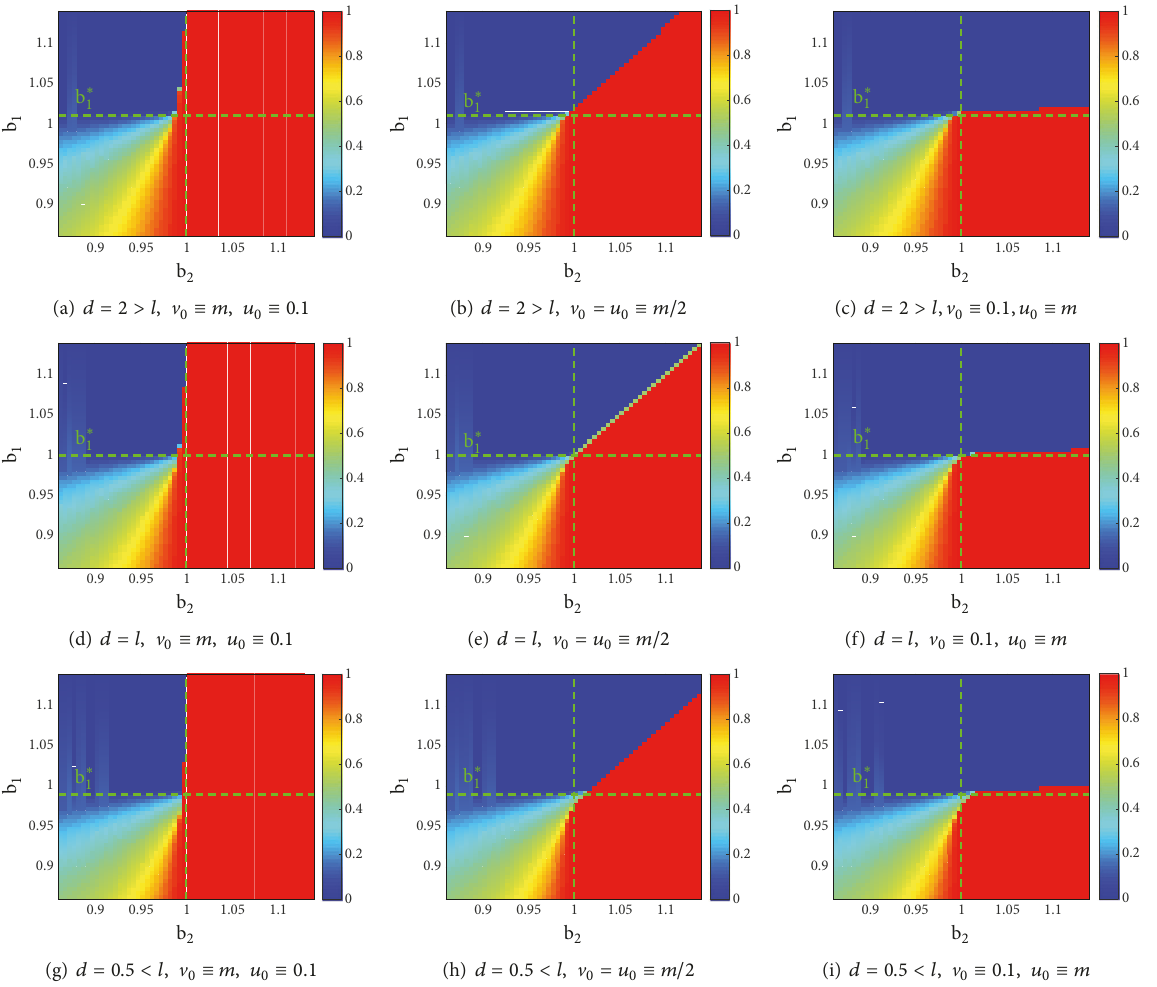
Figure 2: RD versus SDD 2 : in the situation of Theorem 3, the mass ratio ∫ V (𝑡)𝑑𝑥/ ∫(𝑢 + V )(𝑡)𝑑𝑥 of numerical solutions is plotted at 𝑡 = 1000 with the parameters in (14). In the red and blue region SDD 2 and RD prevail, respectively. Unlike Figure 1, the SDD 2 can go extinct near 𝑏 = 𝑏 = 1 if 𝑑 < 𝑙 . 1 2